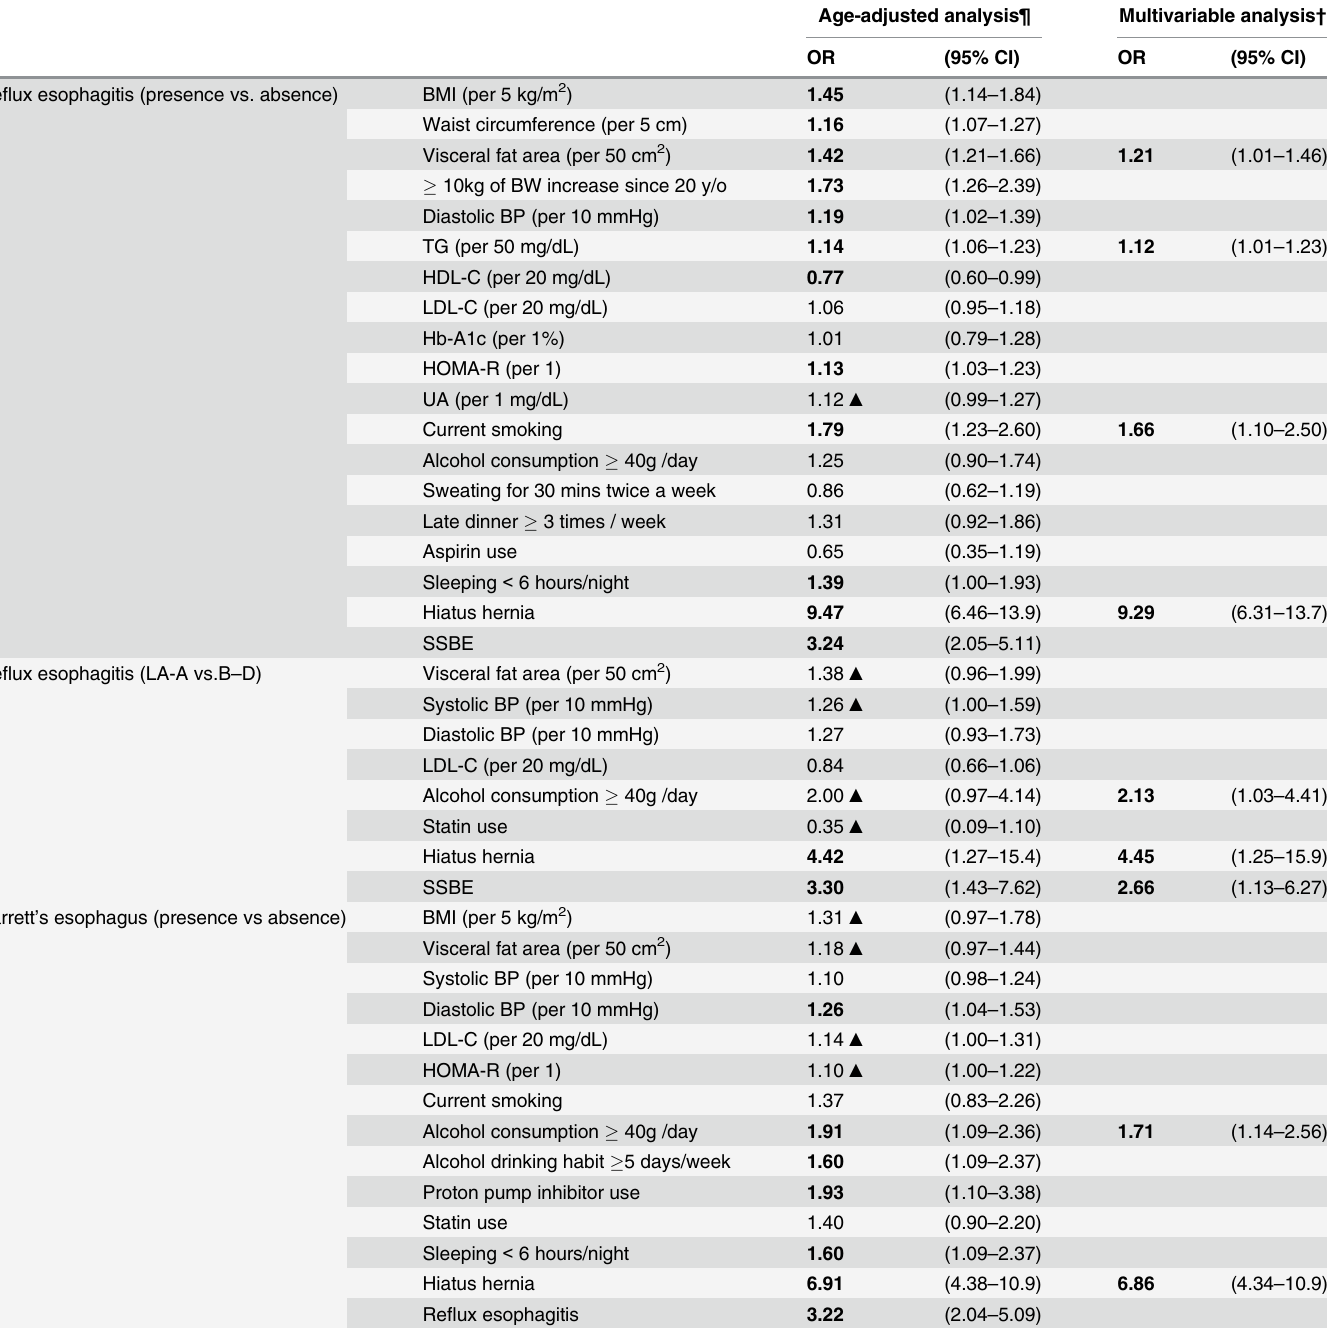
Table 4. Factors associated with reflux esophagitis or Barrett ’ s esophagus in men.